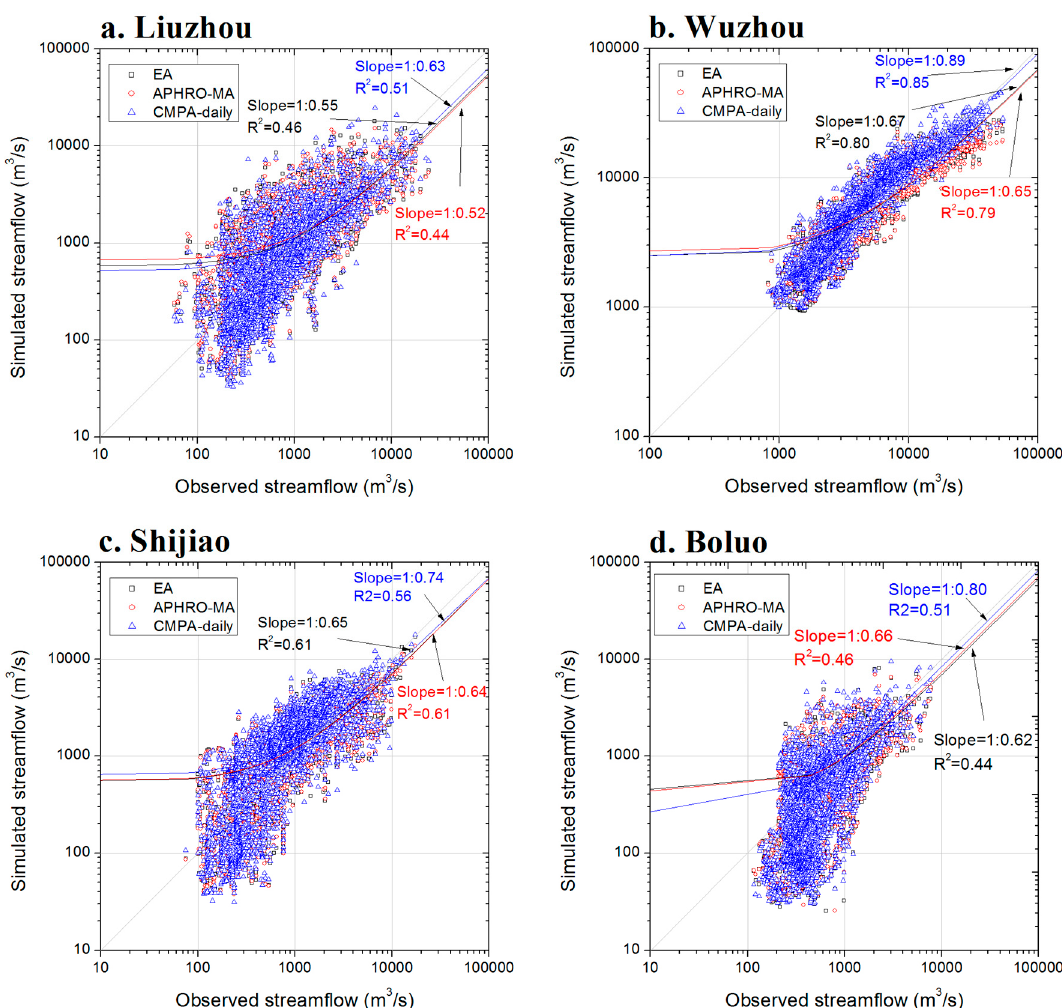
Figure 2. Scatterplots of a comparison between the observed streamflow and simulation from the Coupled Land Surface and Hydrological Model System (CLHMS) model for ( a ) Liuzhou; ( b ) Wuzhou; ( c ) Shijiao; and ( d ) Boluo Stations on the Pearl River from 1998 to 2006 under different precipitation forcings. Table 2. Evaluation of the performance of the Coupled Land Surface and Hydrological Model System (CLHMS).